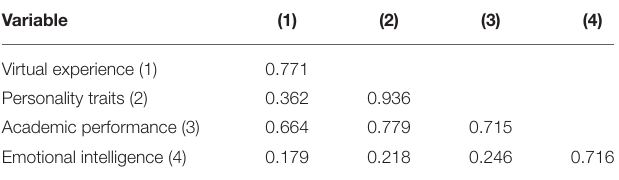
TABLE 1 | Factor loadings. TABLE 2 | Discriminant validity.